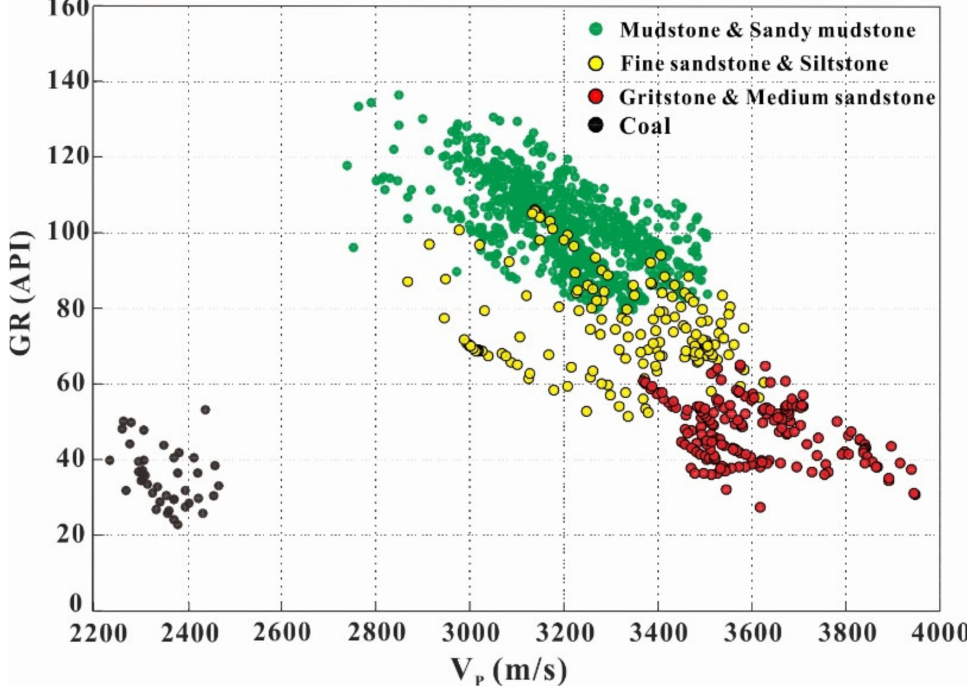
Figure 6. Crossplot of P-wave velocity and gamma of different lithologies in the Shanxi